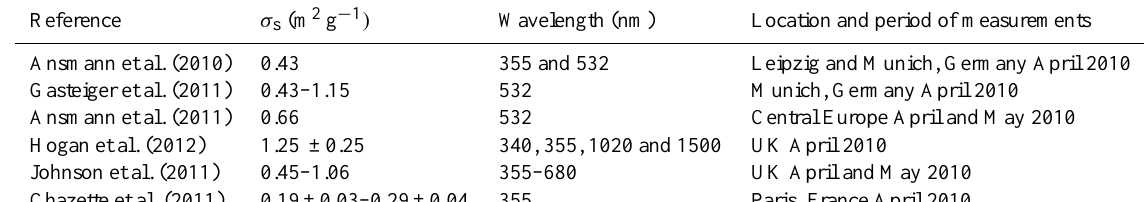
Table 5. Specific cross-section ( σ s ) given in the literature.